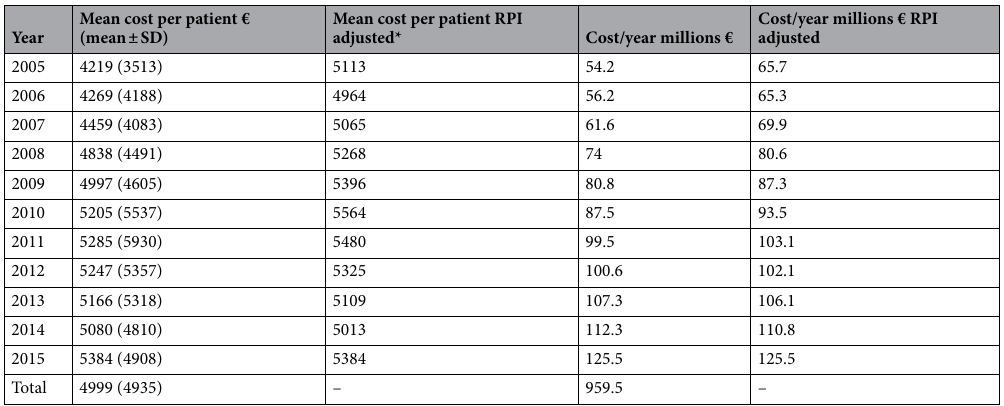
Table 3. Annual costs of hospitalization in gout patients in Spain. RPI retail price index. *Adjusted in relationship to